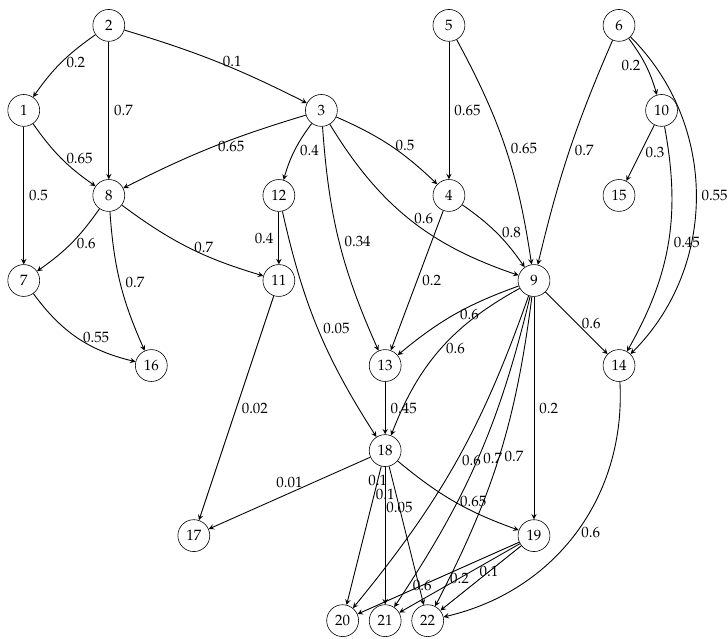
Figure 8. Network representation for scenario ‘ ↓ ’. Network associated with scenario ‘ ↑ ’ is equivalent but with arrows inverted. Table 3. FRM after performing prescribed burns in each sector. Minimum value is highlighted in bold. Chosen Sector FRM (MU) Chosen Sector